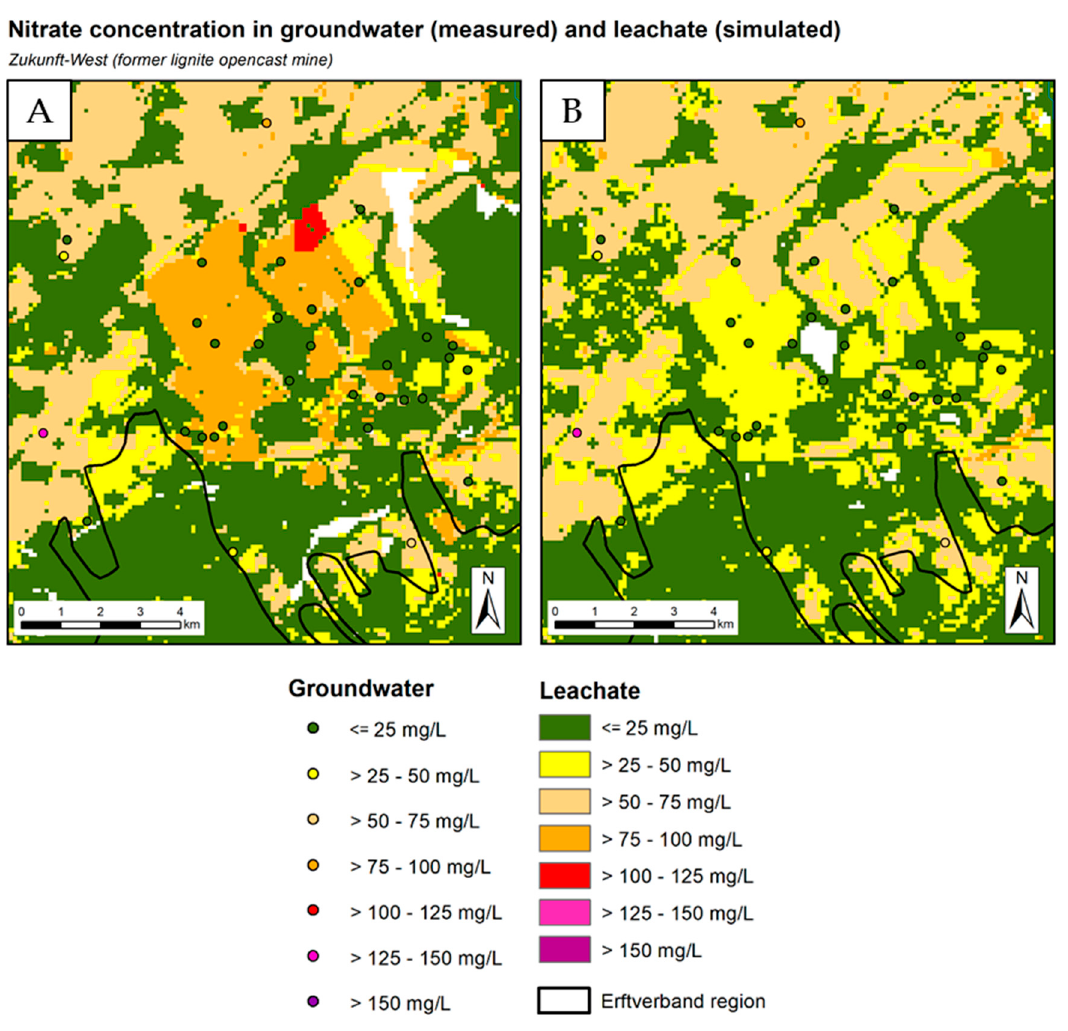
Figure 10. Comparison of the nitrate concentration in the leachate (grids) with measured nitrate concentrations in ground- water (dots) for an area of the former opencast mine Zukunft-West before ( A ) and after ( B ) adapting the denitrification conditions of the soil class “soil made of backfill material”.